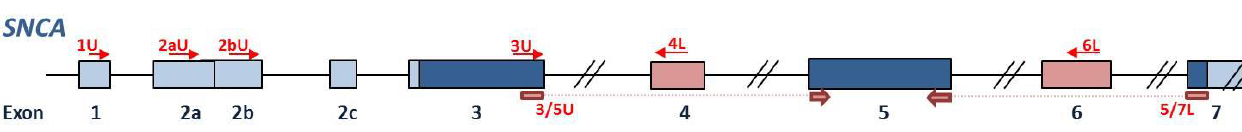
Figure 6. Schematic representation of the SNCA gene showing the localization of the primers listed in Table 6. Arrows represent the location of the primers.